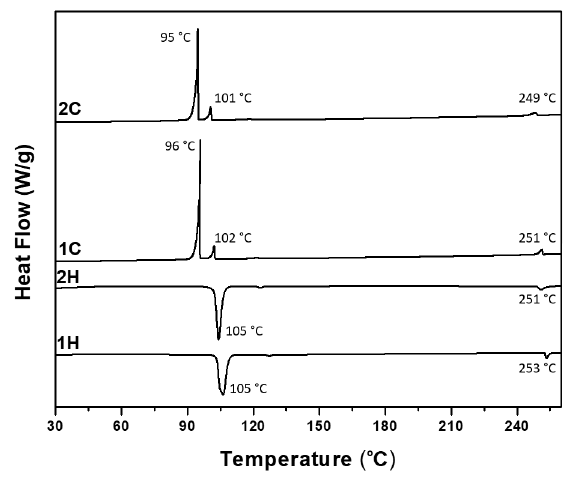
Figure 7. DSC thermograms of EV10 obtained at heating and cooling rates of 10 °C /min.